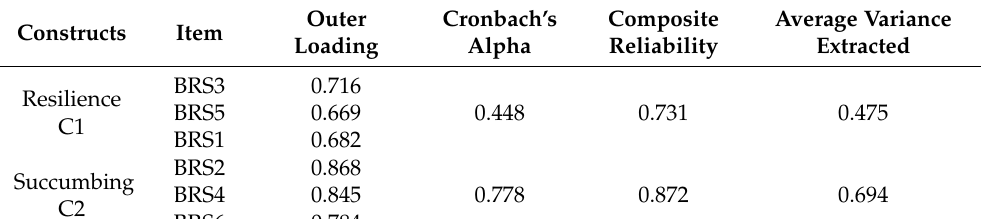
Table 3. Cronbach α , average variance extracted (AVE) values, and composite reliability (CR) among the two constructs.